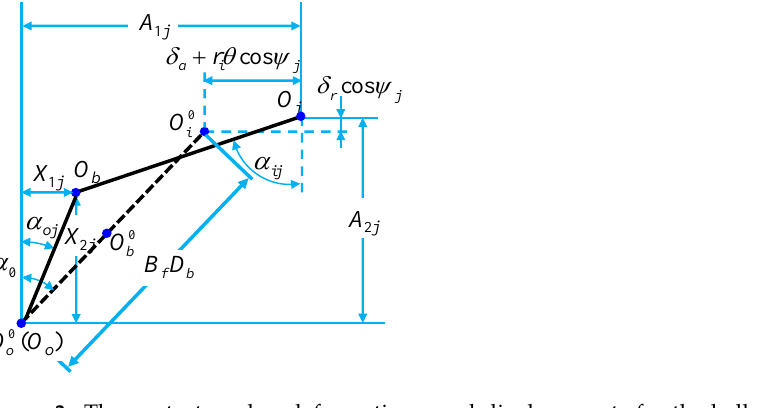
Figure 3. The contact angles, deformations, and displacements for the ball – raceway contacts at azimuth ψ j with the imposed load.